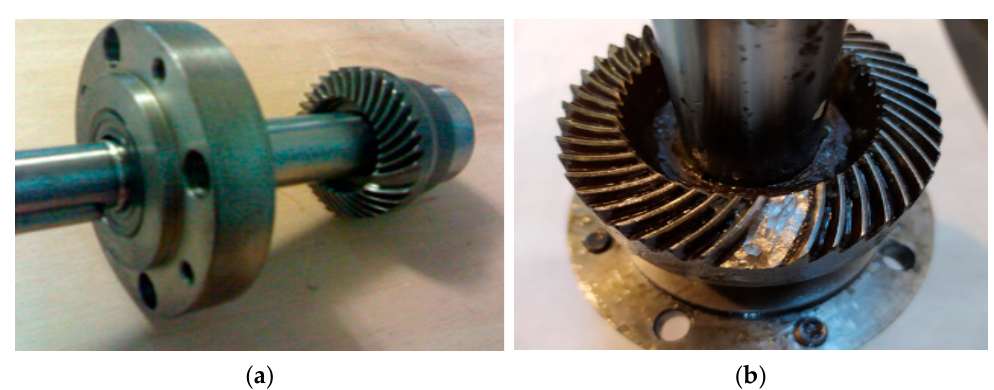
Figure 4. Defected spiral bevel gears ( a ) one tooth broken ( b ) two teeth broken.